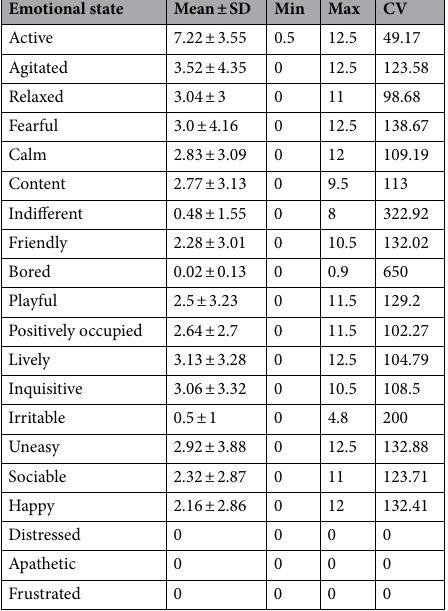
Table 2. Summary statistics of pigs’ QBA terms (in cm; 50 video observations).